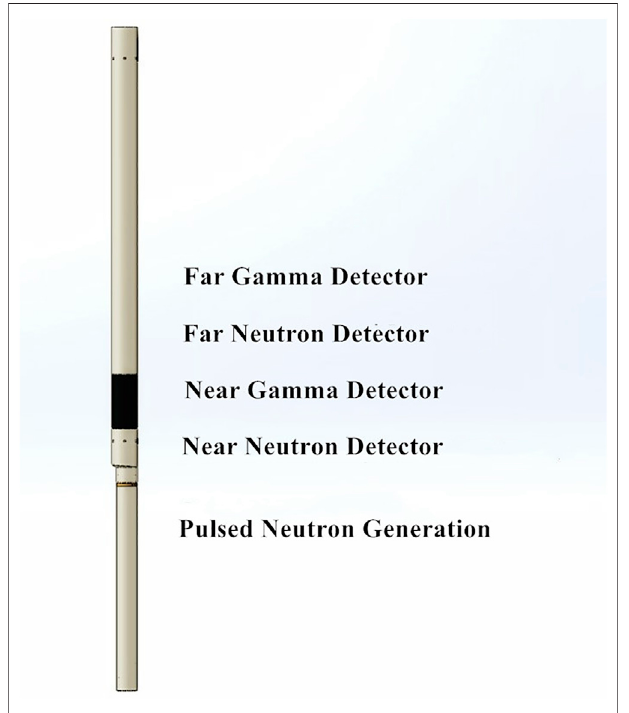
FIGURE 9 | Sonde of the neutron-gamma density logging experimental tool.